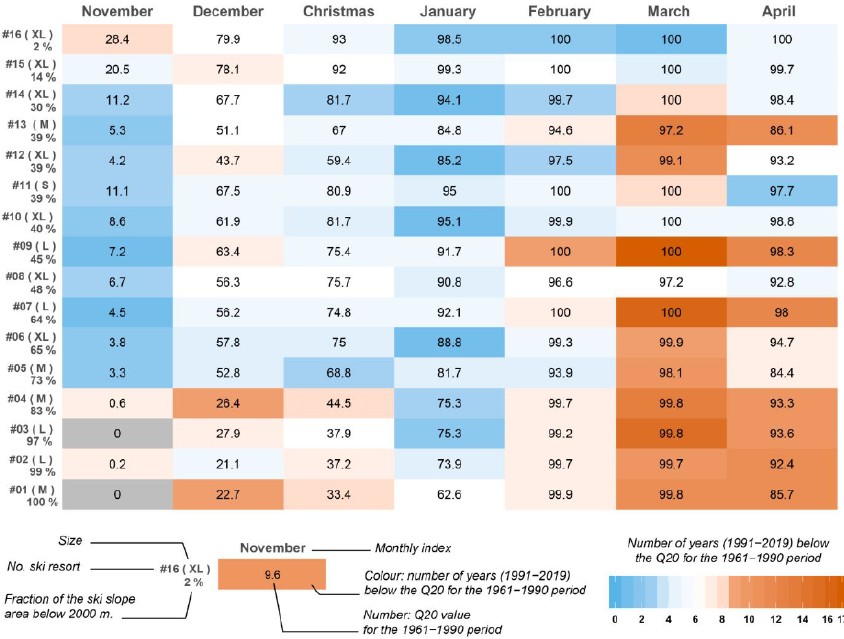
Table 3. Same as Table 2 but for the snowmaking coverage of 2018 throughout the entire period from 1961 to 2019 (including for the reference time period